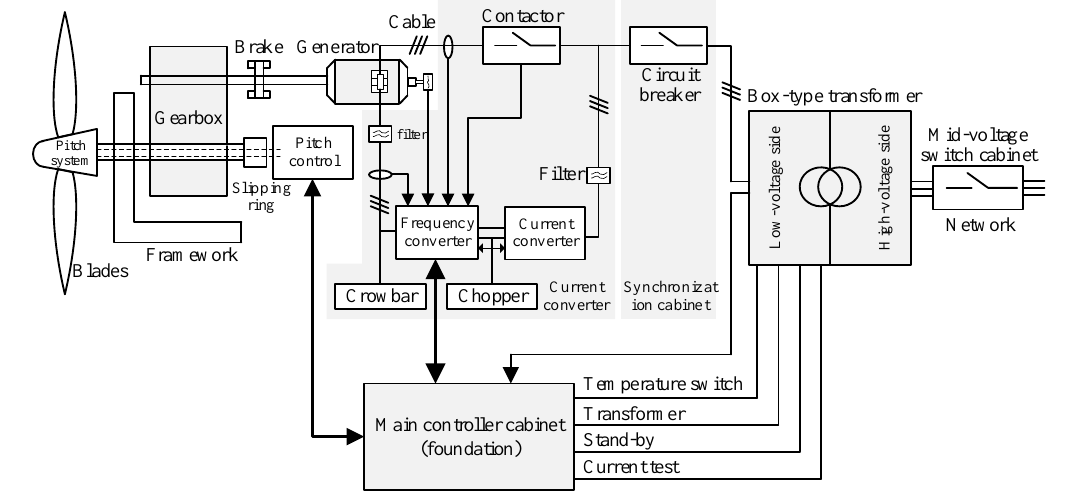
Figure 1. System schematic of offshore wind turbine.